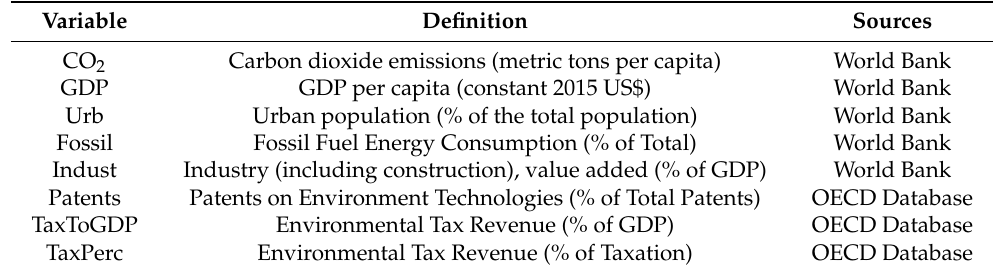
Table 1. Variable Definitions and Data Sources.